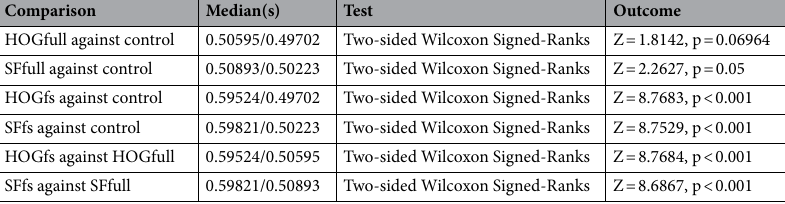
Table 2. Statistical test outcome: same expressions